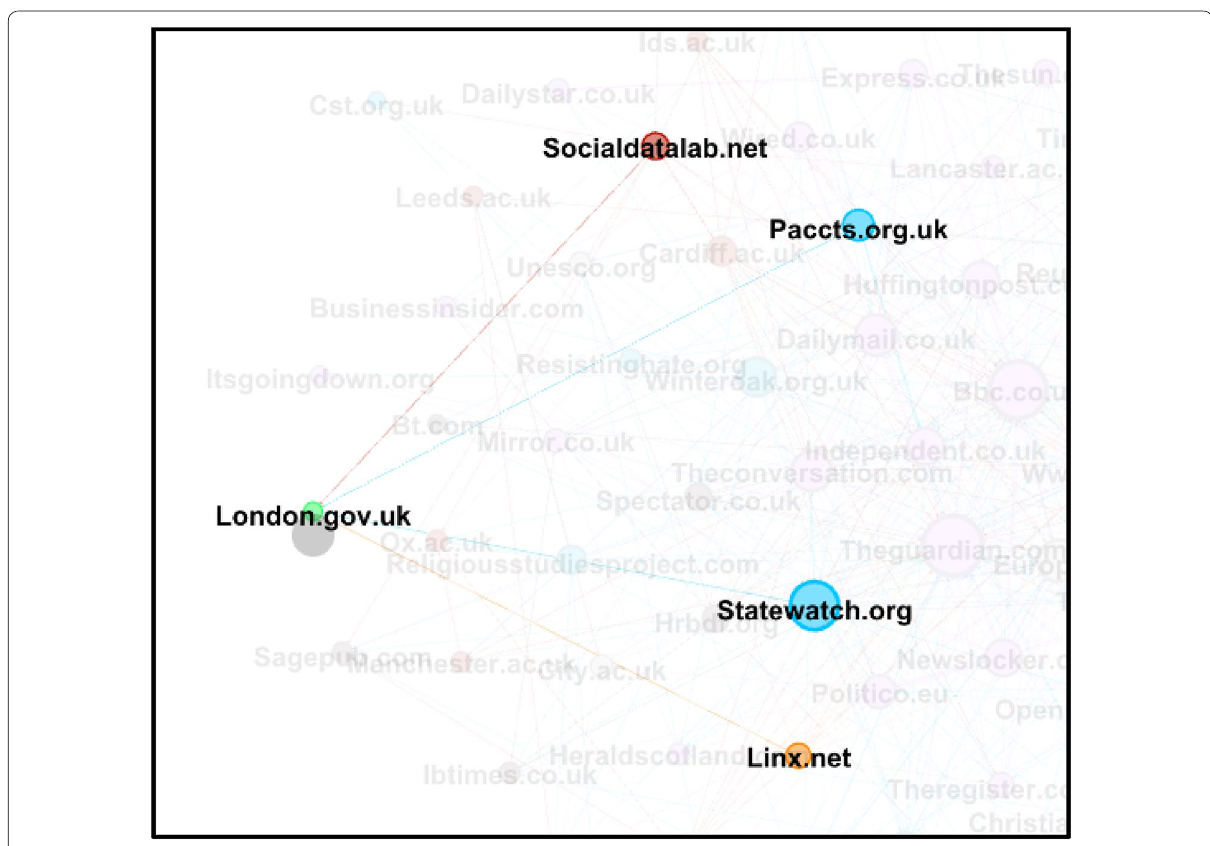
Fig. 2 London government (green node) direct connections